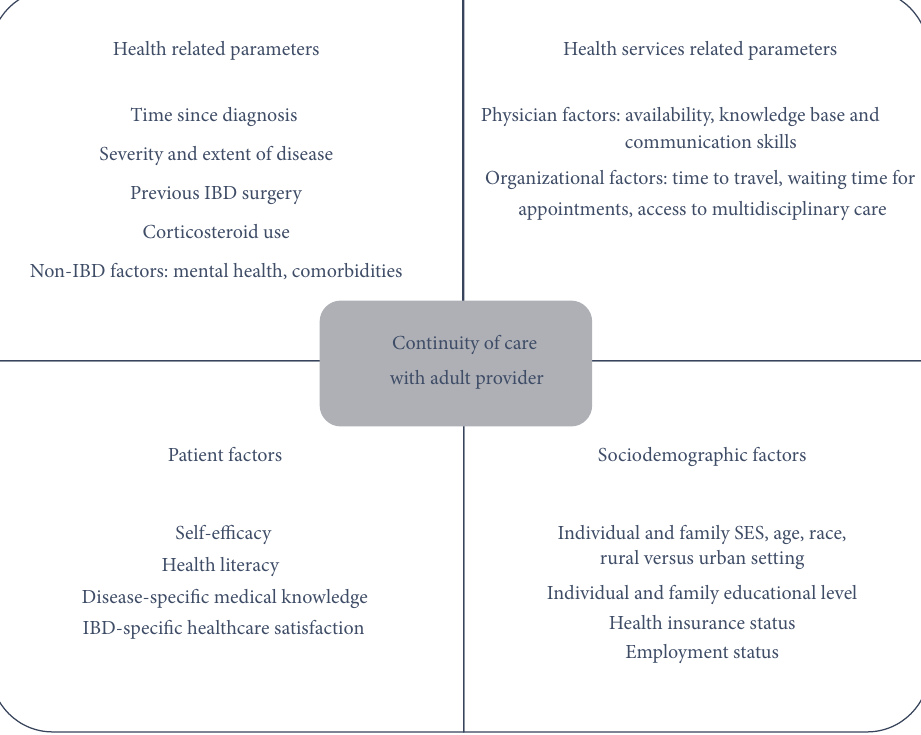
EAI, health providers caring for this subpopulation need